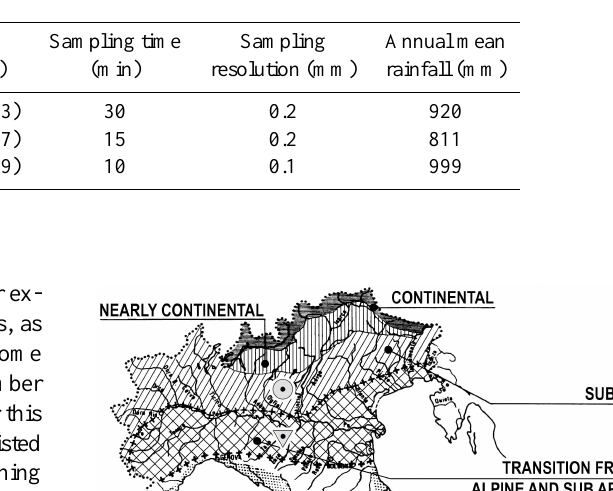
Table 1. Analyzed rainfall time series.